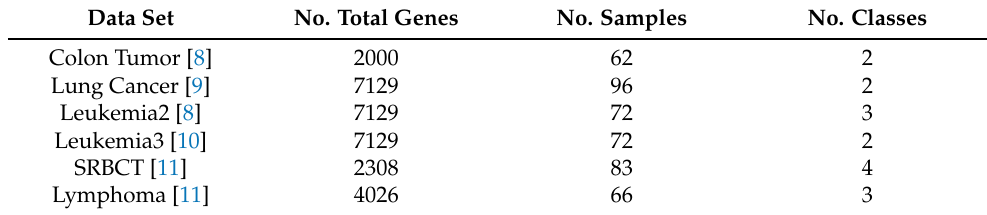
Table 1. Description of microarray data sets.